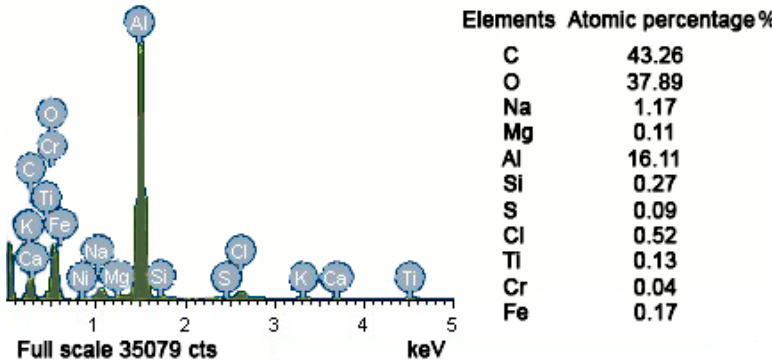
Figure 7. Fracture defect energy spectrum of specimen No. 2.